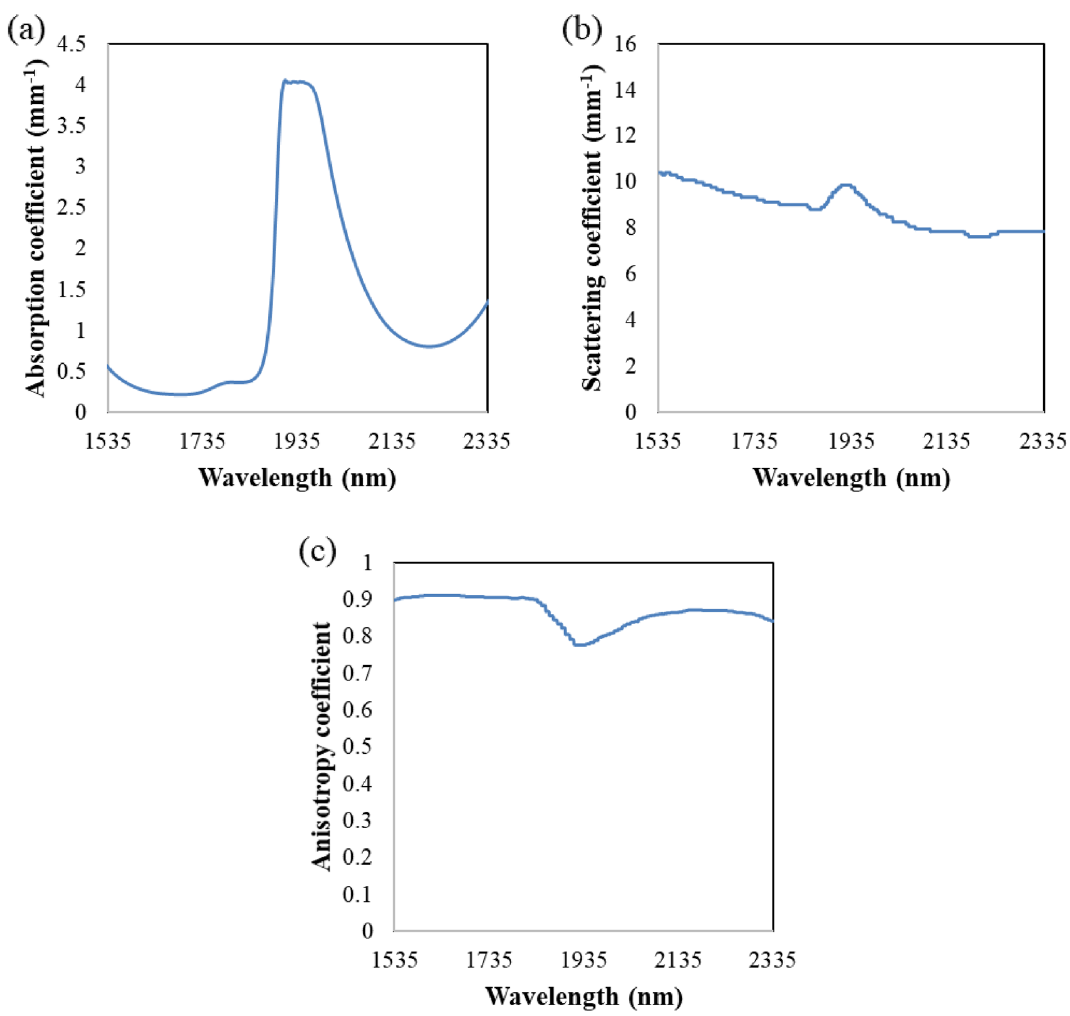
Figure 2. Optical coefficients for the simulated skin layer ( a ) absorption, ( b ) scattering and ( c ) anisotropy coefficient.